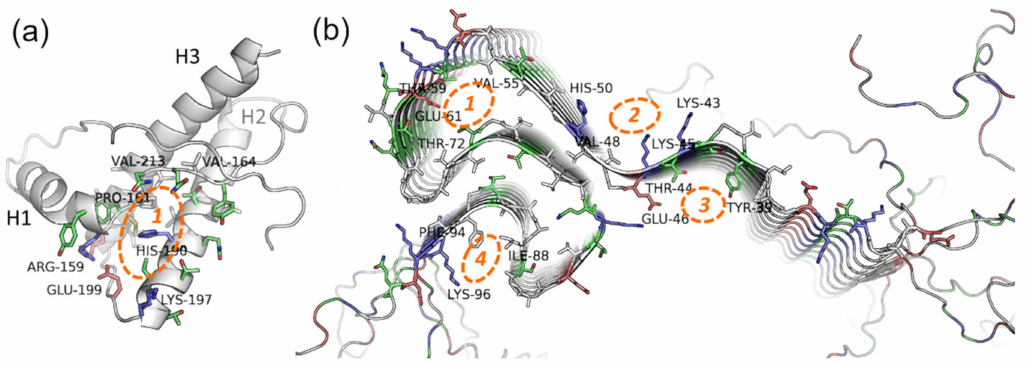
Figure 4. Potential binding sites on the ( a ) native prion protein and ( b ) fibrils of α -synuclein. PDB IDs 1tqb (ovine PrP) and 2n0a (fibrils of human α -synuclein). Blue, red, green, and grey represent basic, acidic, polar, and hydrophobic residues respectively. For the details about the “hotspot” region of PrP (1), see the details in the text; the binding sites localization on α -synuclein fibrils is based on data from